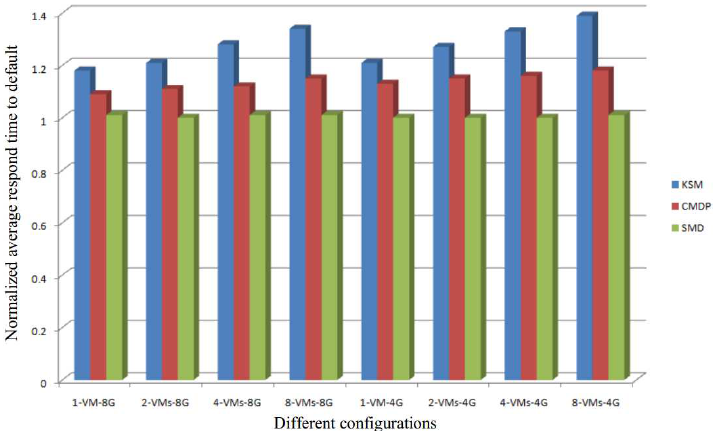
Figure 10. The normalized average response time of our system (SMD) compared to Kernel Samepage Merging (KSM).